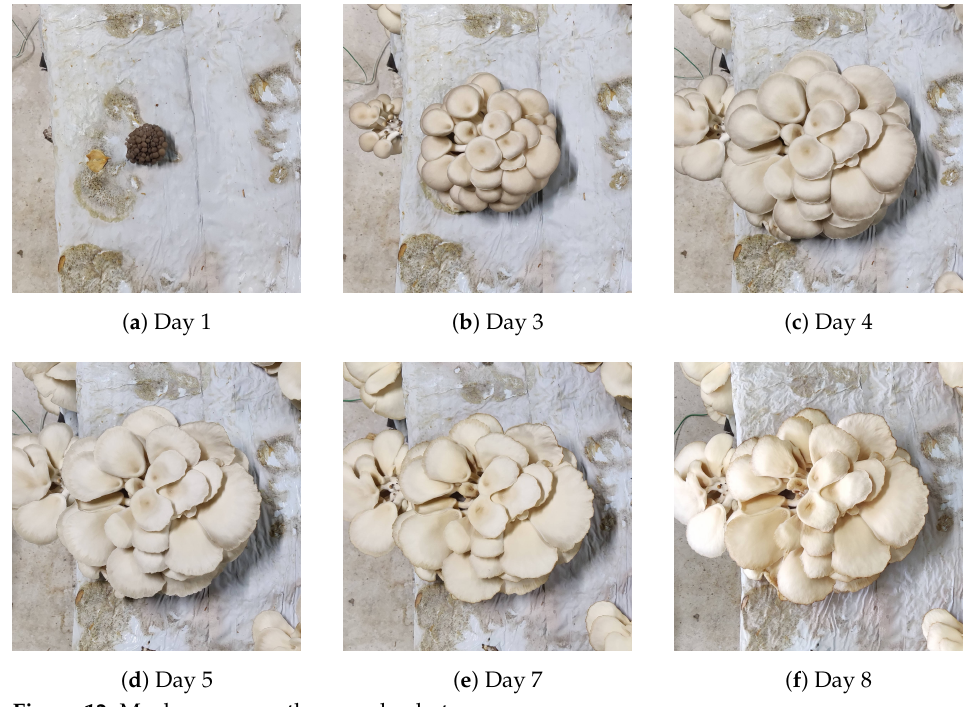
Figure 12. Mushroom growth example